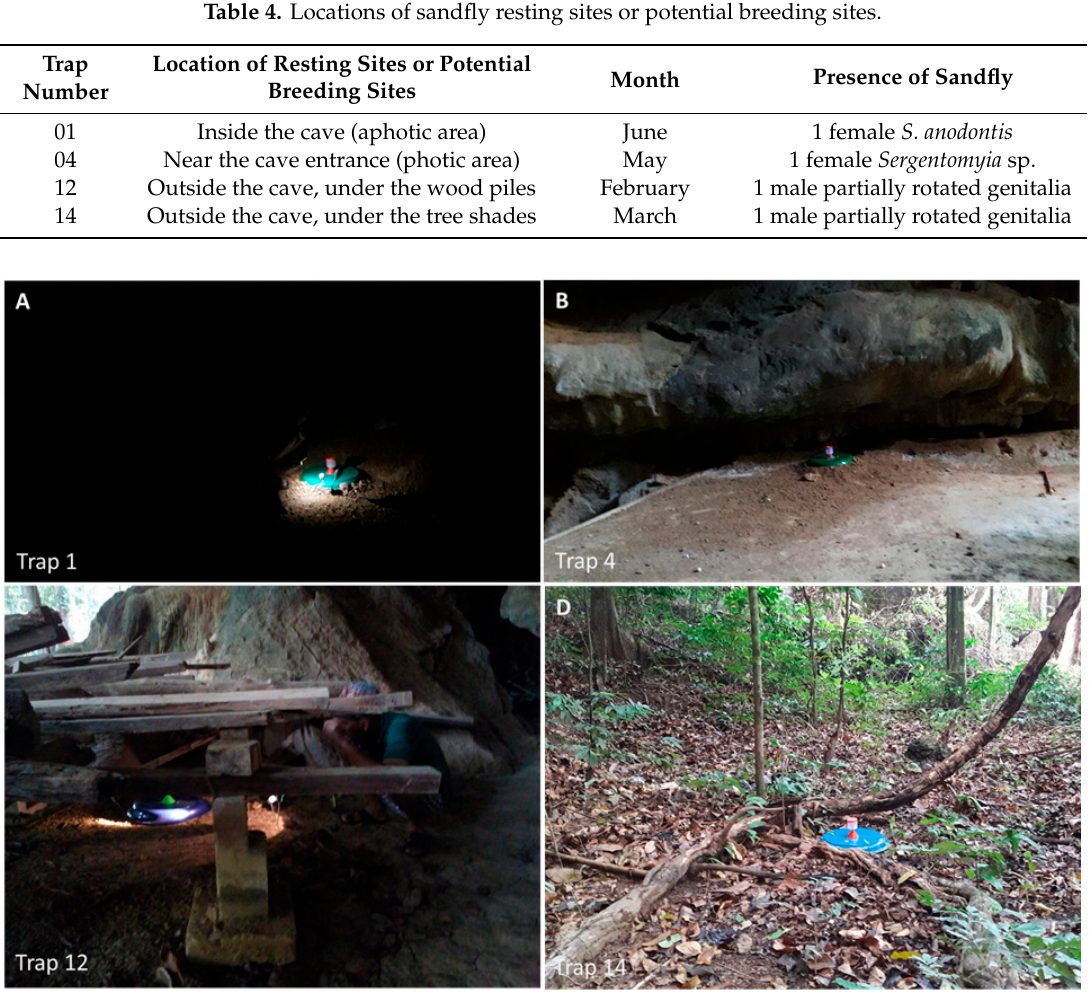
Figure 4. Sandfly resting or potential breeding sites around the cave area. Resting sites and potential breeding sites were found inside in the aphotic area of the cave ( A ), near the cave entrance ( B ), and outside the cave under the wood piles and tree shades ( C , D ), respectively. Table 3. Proportion of external genitalia rotations of male sandflies